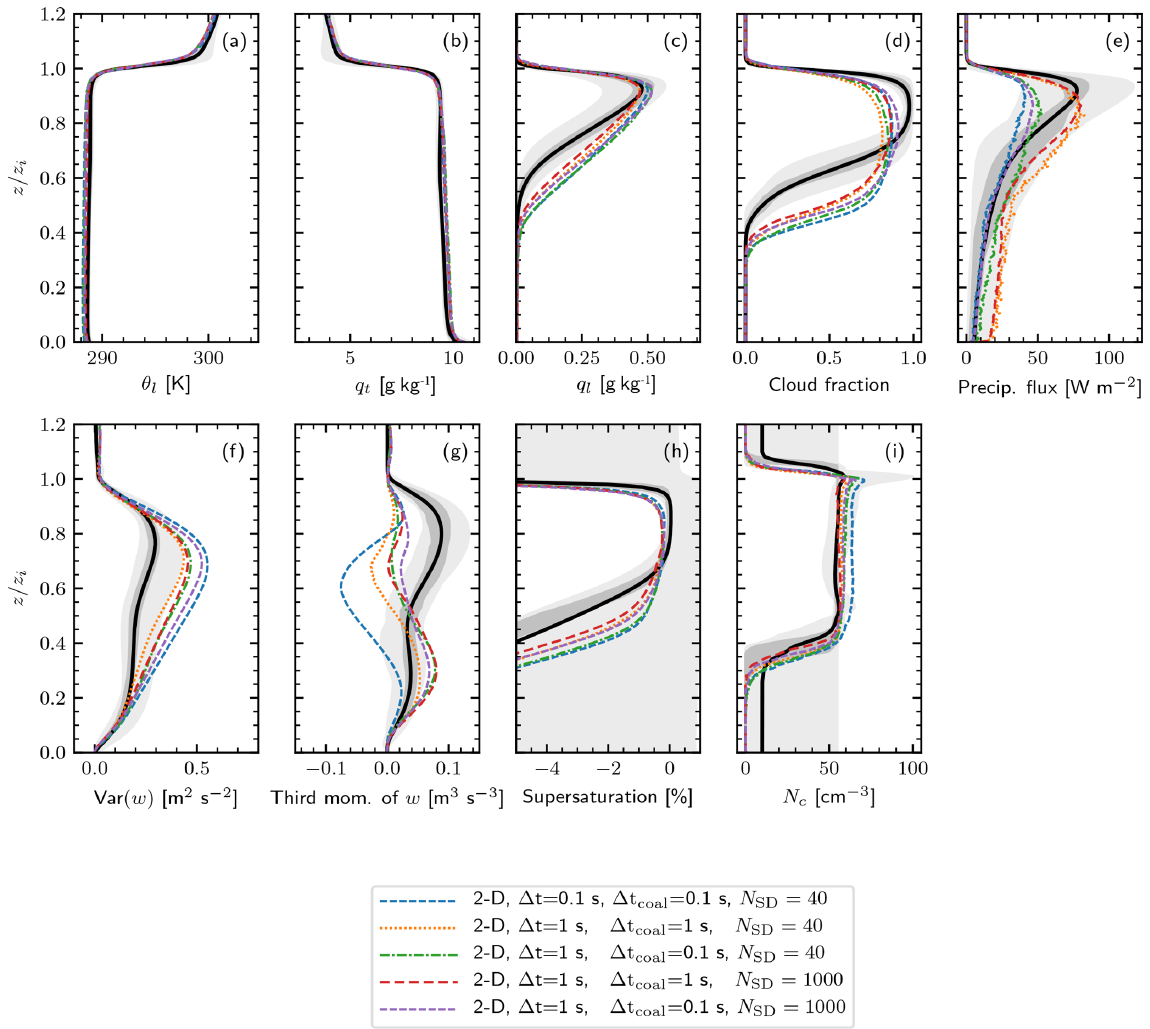
Figure 4. The 2-D UWLCM results. As in Fig. 3, but showing horizontally averaged profiles of liquid water potential temperature (defined in Ackerman et al., 2009), total water mixing ratio, liquid water mixing ratio, cloud fraction (defined in Appendix A), precipitation flux (defined in Appendix A), variance of vertical velocity, third moment of vertical velocity, supersaturation and concentration of droplets in cloudy cells. The vertical axis is altitude normalized by inversion height. The profiles are averaged over the 2 to 6h period.